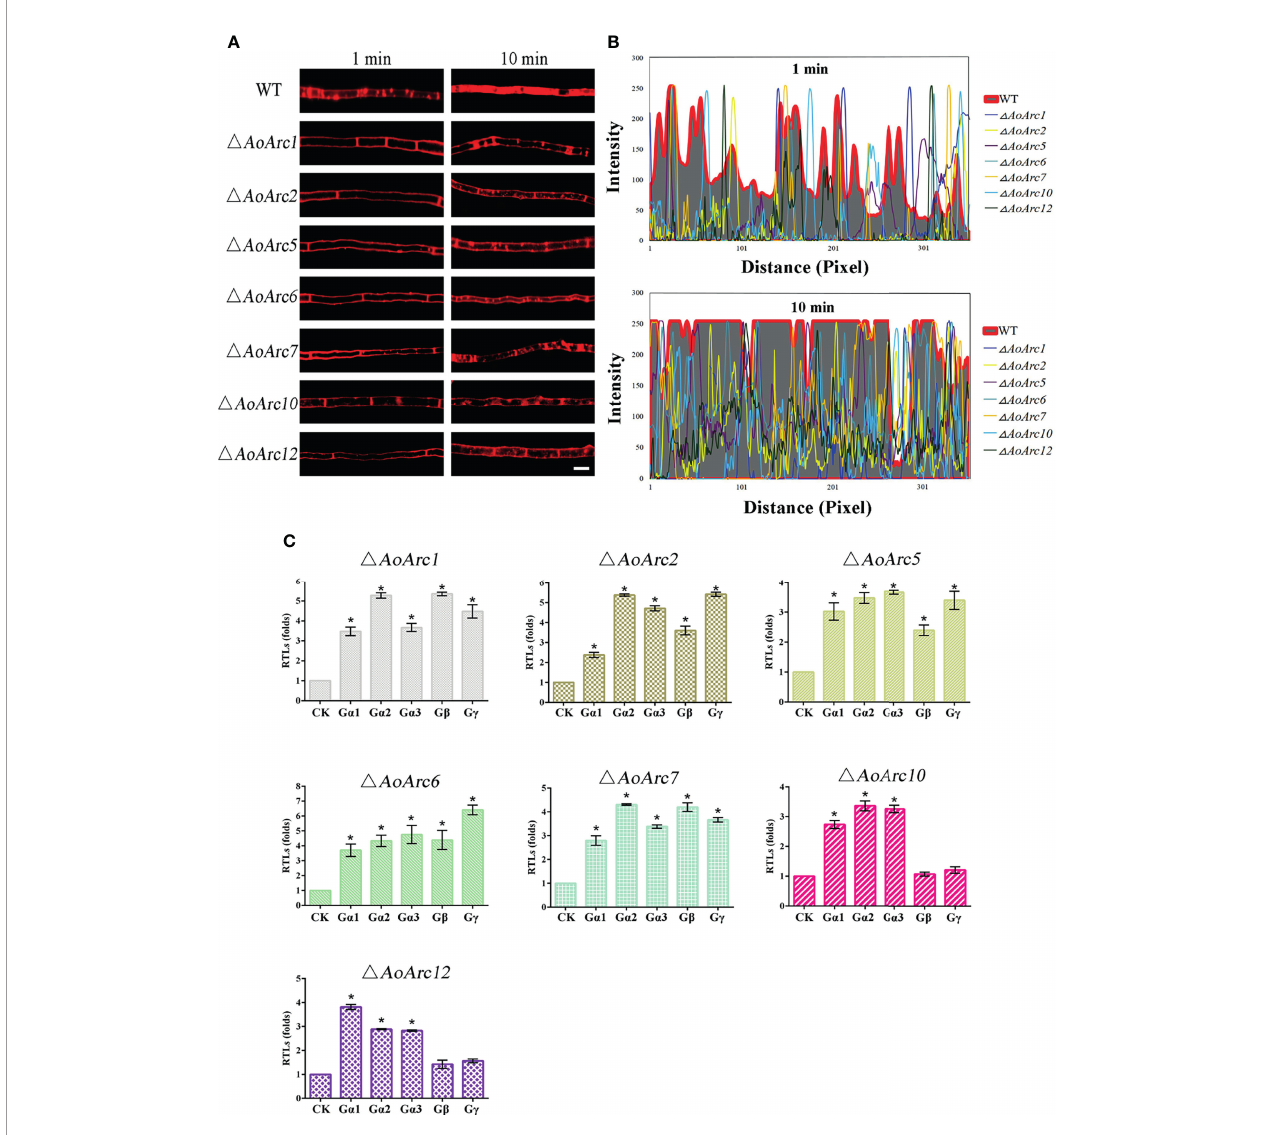
FIGURE 6 | Arrestin is involved in the regulation of fungal endocytosis. (A) Comparison of FM4-64 staining between WT and AoArc mutants; the samples were inspected with an inverted fl uorescence microscope. Bar: 10 m m. (B) Analyze the fl uorescence intensity of FM4-64 after staining. Top: dyeing for 1 min; Bottom: dyeing for 10 min. (C) Comparison of the transcription level of G protein subunits between WT and AoArc mutant strains. CK ( A. o b -tubulin ) is expressed as the standard of RTL statistical analysis. Each experiment was performed three times. Error bars: standard deviation; asterisk: signi fi cant difference between mutant and WT (Tukey ’ s HSD, p <